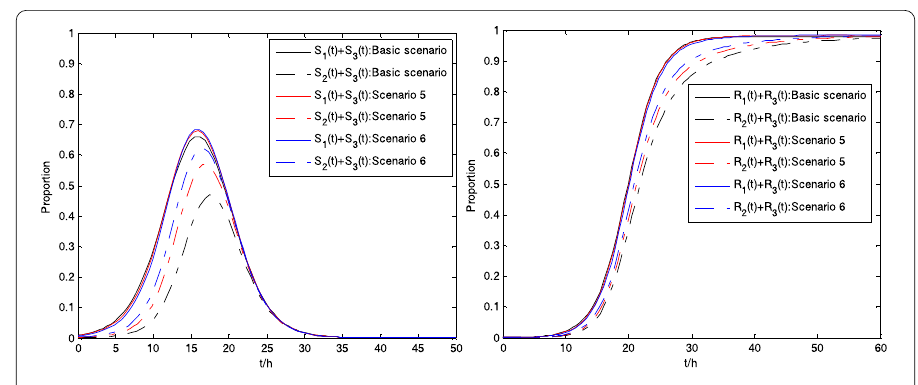
Figure 8 Proportion of spreaders and stiflers over time in different occurrence time differences